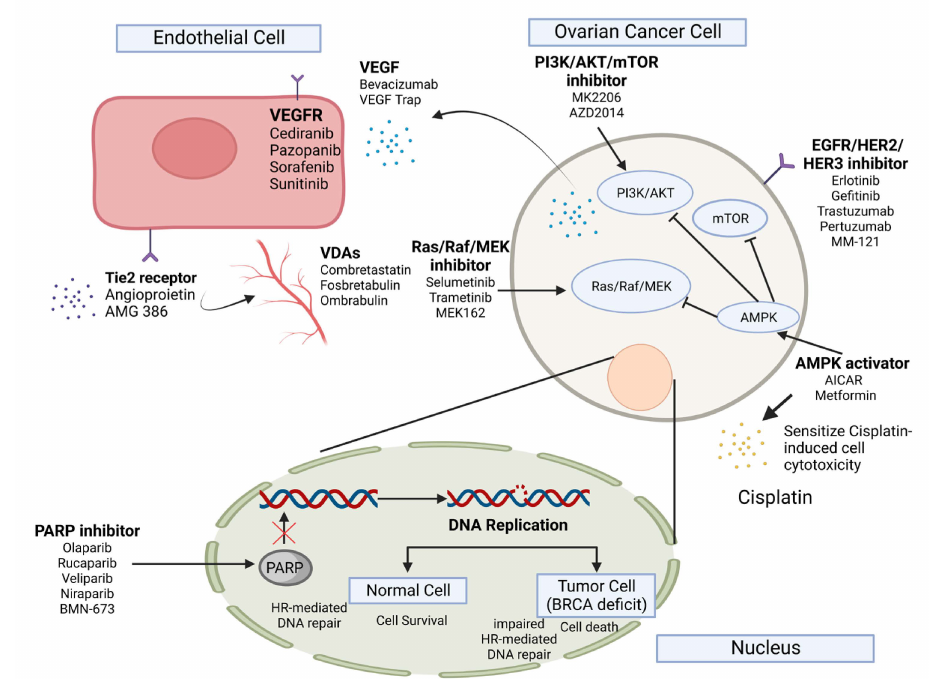
Figure 1. Common targeted therapy in ovarian cancer. Clinical trials of Bevacizumab, a monoclonal antibody against vascular endothelial growth factor A (VEGF-A), have indicated significant efficacy against ovarian cancer and have been proposed to use as a first-line therapy with